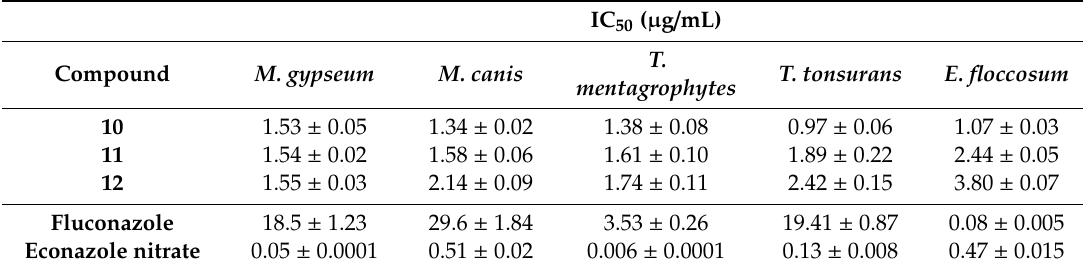
Table 3. IC 50 values of compounds 13 – 15 , Econazole nitrate and Fluconazole on dermatophytes. Each value is the mean of three